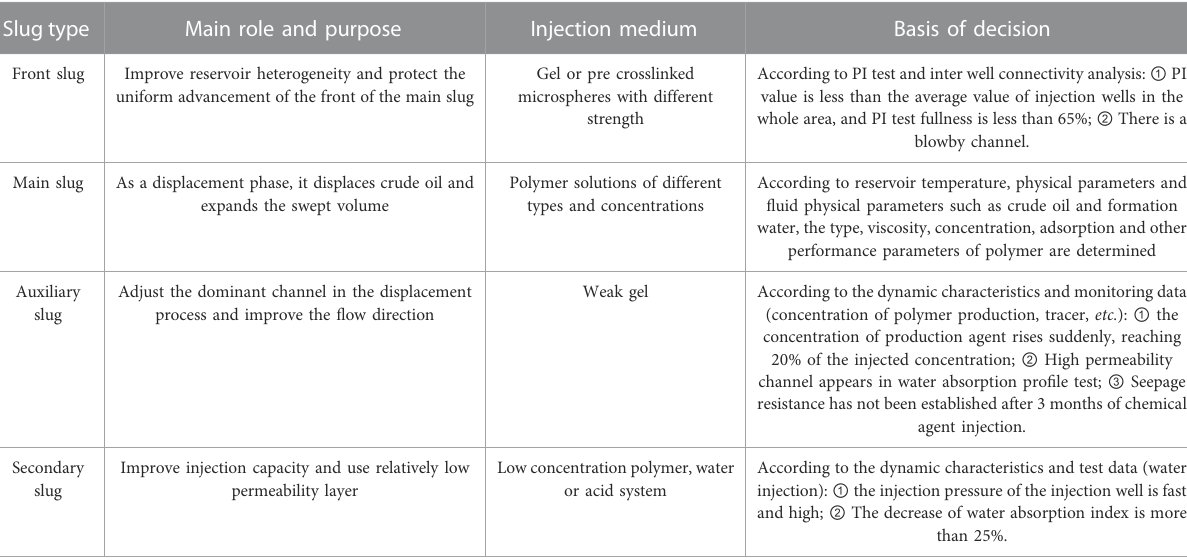
TABLE 1 Design of discontinuous chemical fl ooding